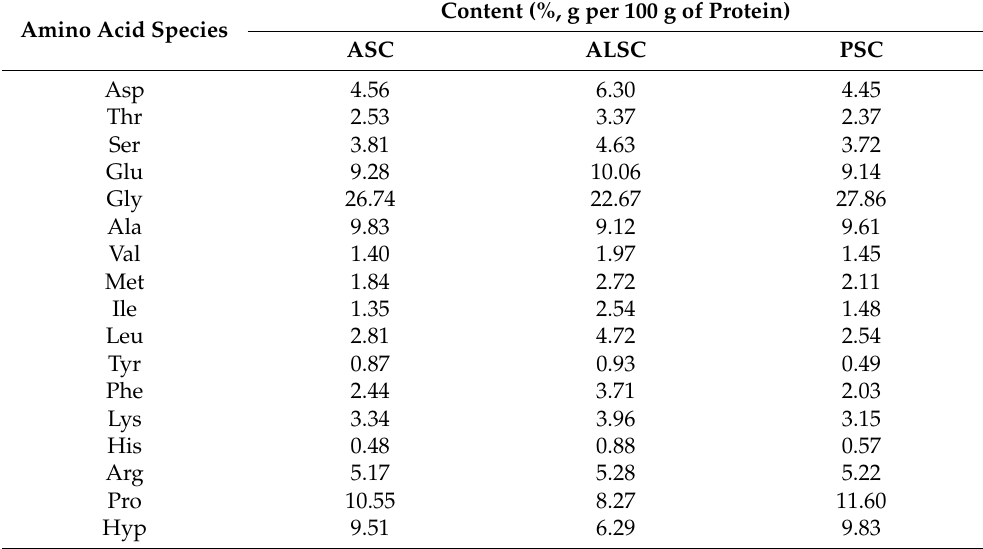
Table 2. Amino acid compositions of chicken bone